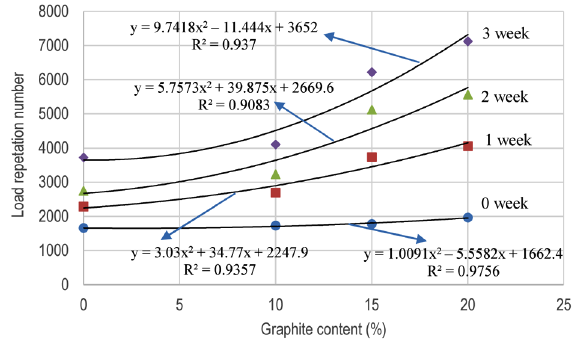
Fig. 12. The load repetition number-graphite ratio relation of the